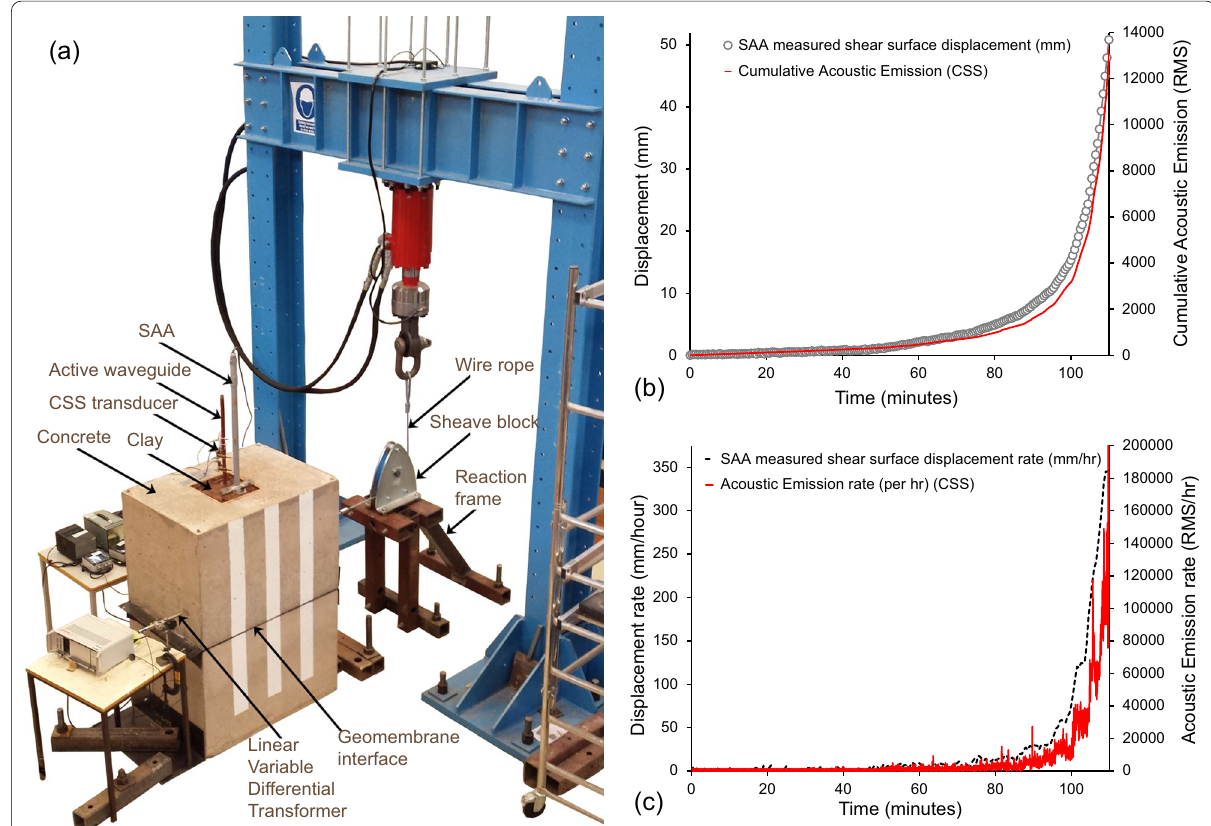
Fig. 3 Large-scale slope failure physical model used to accelerate the top box relative to the bottom and to compare displacement behaviour with AE measured using the CSS system: a annotated photograph of the apparatus; b CSS cumulative AE and SAA measured displacement time series; and c CSS AE rate and SAA measured velocity time series (modified after Smith et al. 2017a and Dixon et al.